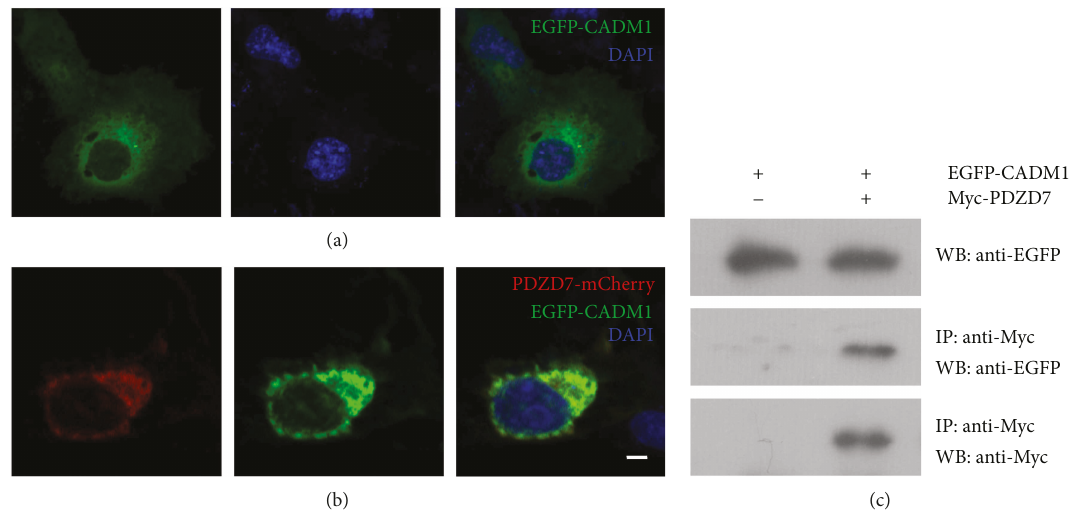
Figure 4: Interaction of PDZD7 with CADM1 in transfected cells. Expression vectors were transfected into COS-7 cells, and the subcellular localization of target proteins was determined using confocal microscopy. (a) EGFP-CADM1 localized in the cytoplasm of COS-7 cells. (b) When expressed together, PDZD7-mCherry colocalized with EGFP-CADM1. Scale bar: 10 μ m. (c) Western blots showed that CADM1 was coimmunoprecipitated with PDZD7. Expression vectors were transfected into HEK293T cells to express epitope-tagged PDZD7 and CADM1 proteins, and cell lysates were subjected to immunoprecipitation. IP indicates antibody used for immunoprecipitation, and WB indicates antibody used for detection.